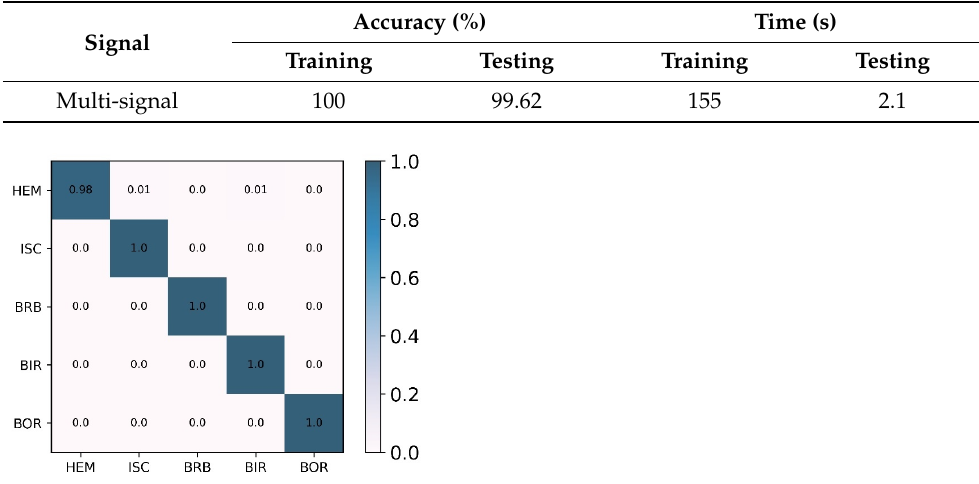
Figure 13. Confusion matrix for multi-signal feature fusion